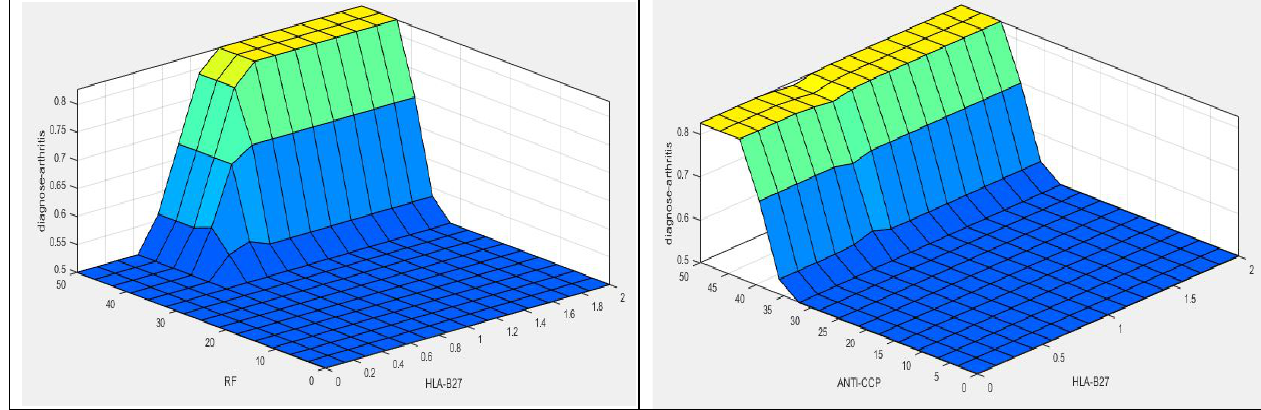
Fig.6a. Rule Surface for RF and HLA-B27 Fig. 6b. Rule Surface for Anti-CCP and